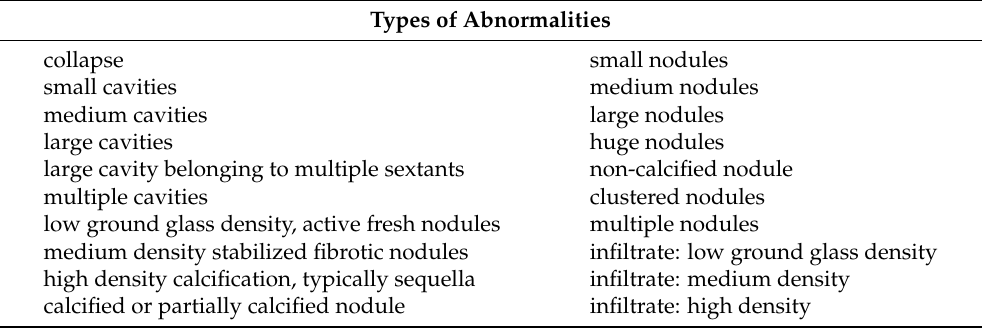
Table 2. Twenty features derived from the presence of abnormalities that are localized to different